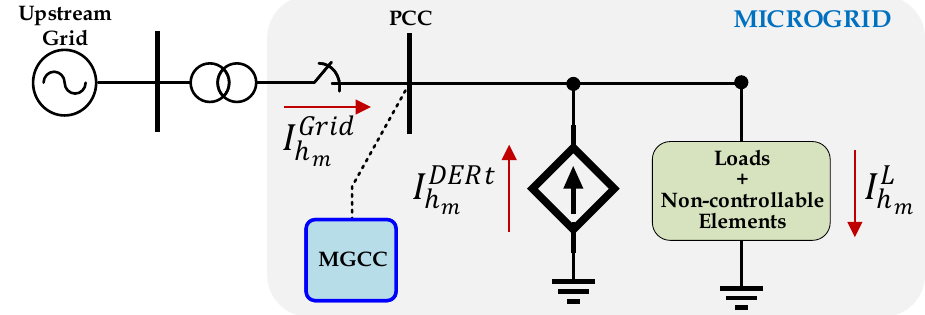
Figure 5. Kirchhoff’s current law applied to the MG peak current